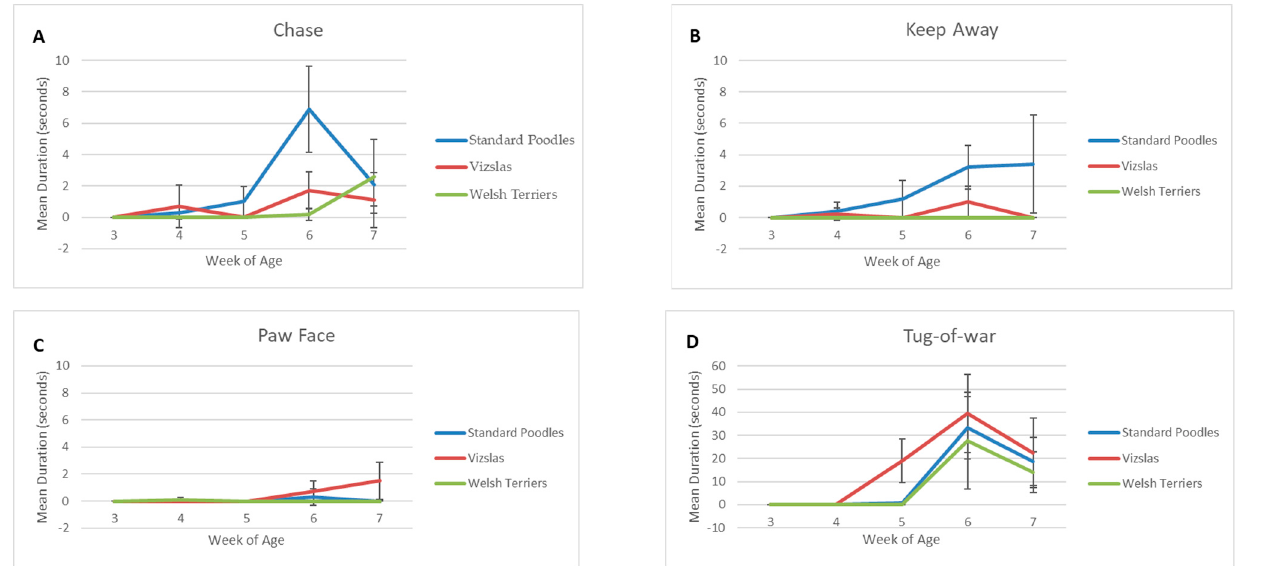
Figure 3. Individual Behaviors in the social (SOC) Play Context . Mean durations in seconds for individual behaviors in the social (SOC) play context for pups across breeds with 95% CI. ( A ) chase , ( B ) keep away, ( C ) paw face, ( D ) tug-of-war by age in weeks. Breeds did not differ in use of tug-of-war during play during weeks 3 ( p = 0.97), 4 ( p = 0.84), 6 ( p = 0.15), or 7 ( p = 0.43). During week 5, Vizslas played more tug-of-war than Poodles ( p = 0.018) and Terriers ( p = 0.002) (Figure 3D, Appendix A Table A3).